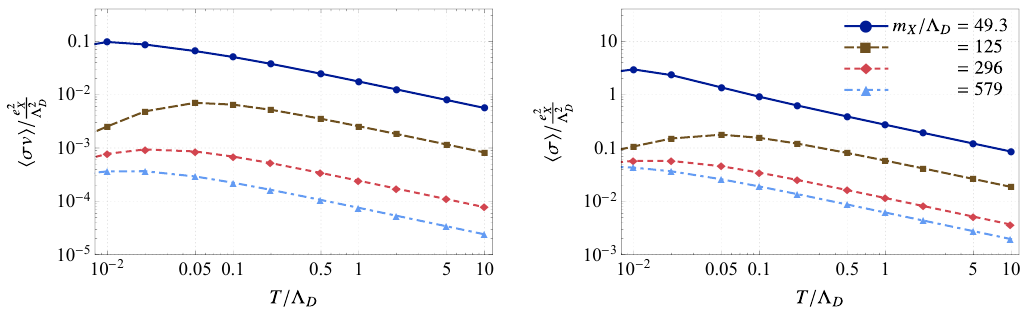
Figure 8. Results of thermally-averaged radiative quarkonium production cross section h (cid:27)v i (left panel) and h (cid:27) i (right panel) as a function of temperature for di(cid:11)erent values of m X = (cid:3) D